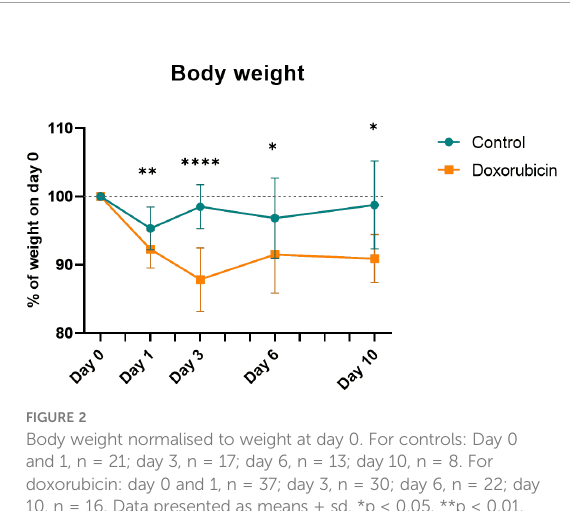
(Figure 4). The total uptake was calculated as average SUV BW × VOI size. VOI size is depicted in Supplementary Figure S5 and